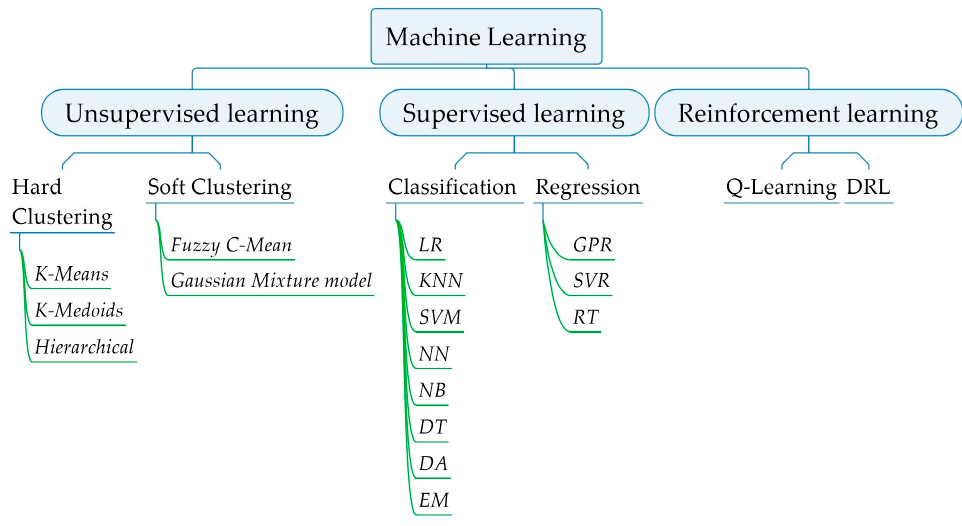
Figure 9. ML techniques for fault diagnosis in EPS [95].